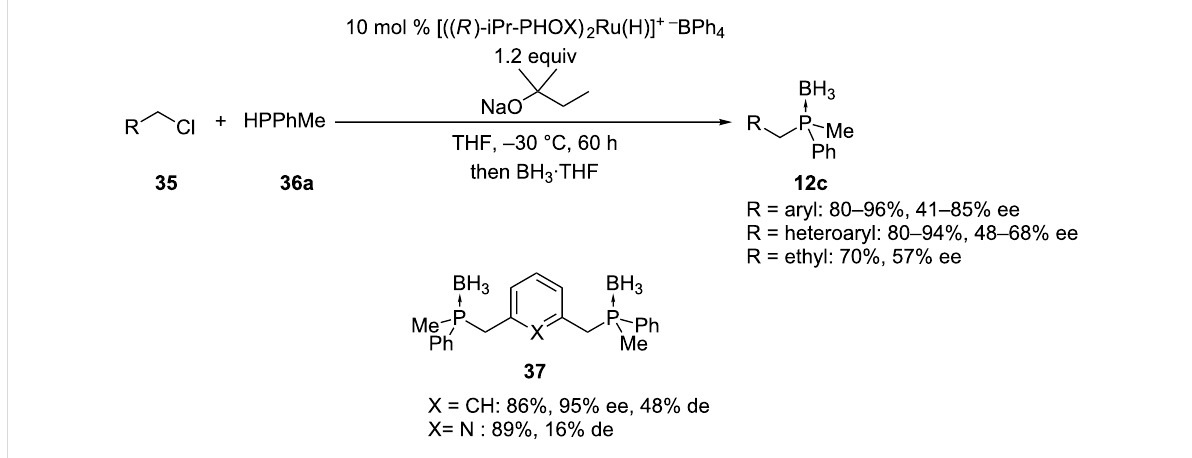
Scheme 11: Ru-catalyzed asymmetric phosphination of benzyl and alkyl chlorides 35 with HPPhMe ( 36a , PHOX = phosphinooxazoline).